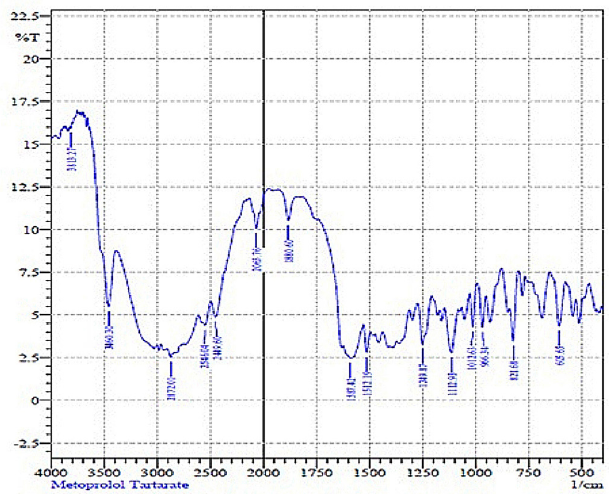
FIGURE 1 - FT-IR spectrum of metoprolol tartrate.